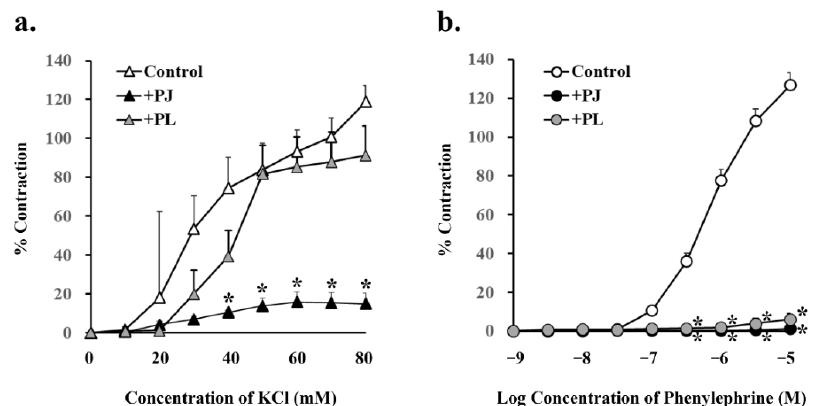
Figure 5. Concentration-response curves for ( a ) potassium chloride- and ( b ) phenylephrine-induced vasocontractions in rat superior mesenteric artery rings ( n = 4–6). Curves were constructed for experiments with no pretreatment (control) and pretreatment with persimmon juice (PJ) (1 g/L) and persimmon leaf (PLs) (1 g/L) powder. Results (mean ± standard error of mean) are expressed as a percentage of the previous tone induced by potassium chloride (60 mM). * p < 0.05 vs. each control (Dunnett’s